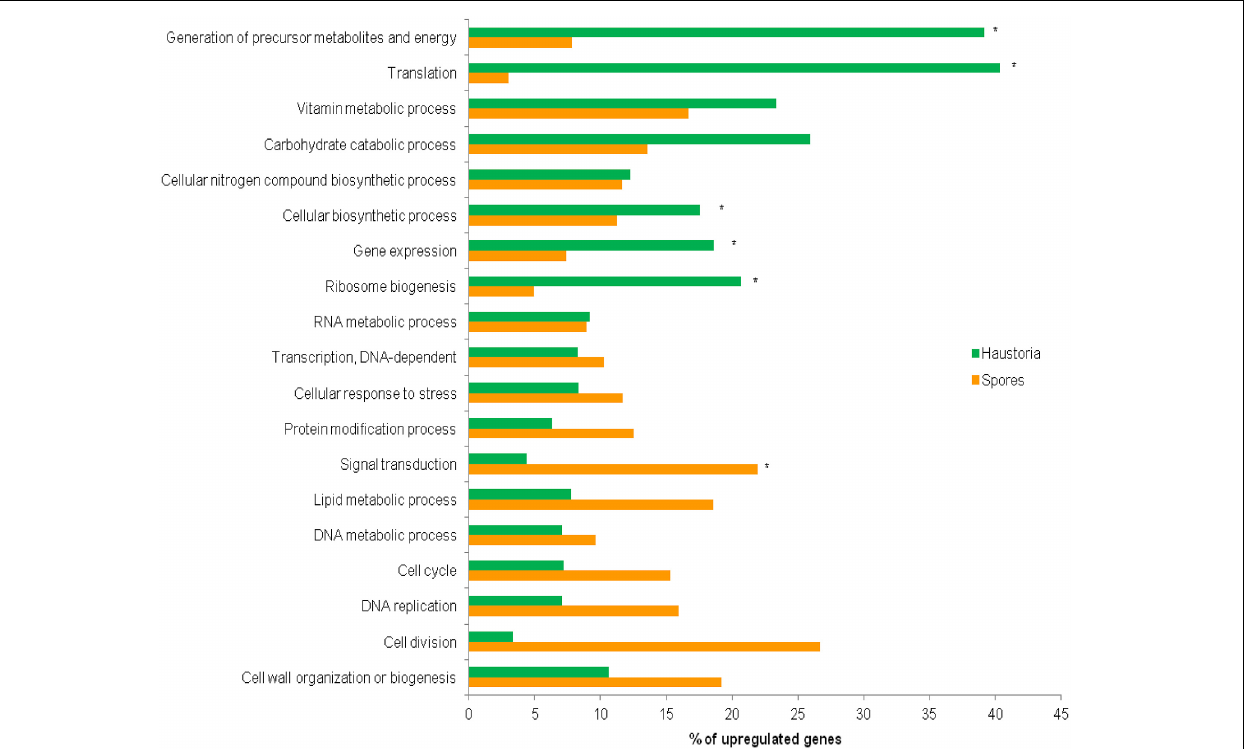
biological process GO terms are shown on the Y-axis. Percentages of genes differentially expressed in each tissue belonging to the nominated categories are shown on the X-axis. Asterisks indicate the categories over-represented in either developmental stage found after applying Fisher’s exact test, FDR < 0.05.